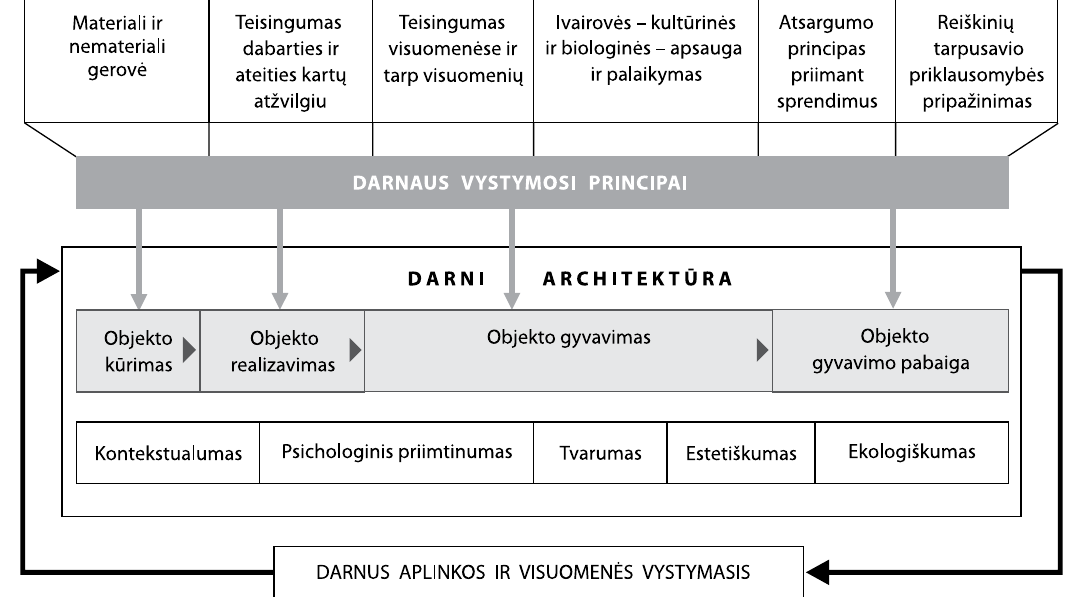
Fig. 1. Proposed notion of sustainable architecture. Generalized principles of sustainable development presented in the scheme are formulated by D. throsby